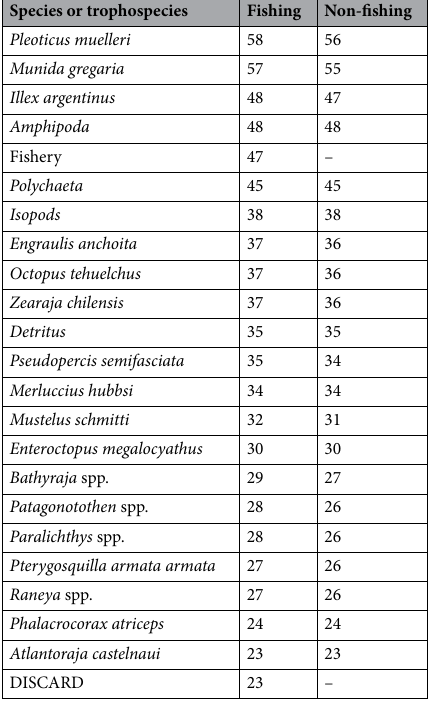
Table 1. Degree values (i.e. number of total interactions of each node) for the top 23 species and trophoespecies of the system from the non-fishing scenario and from the fishing food